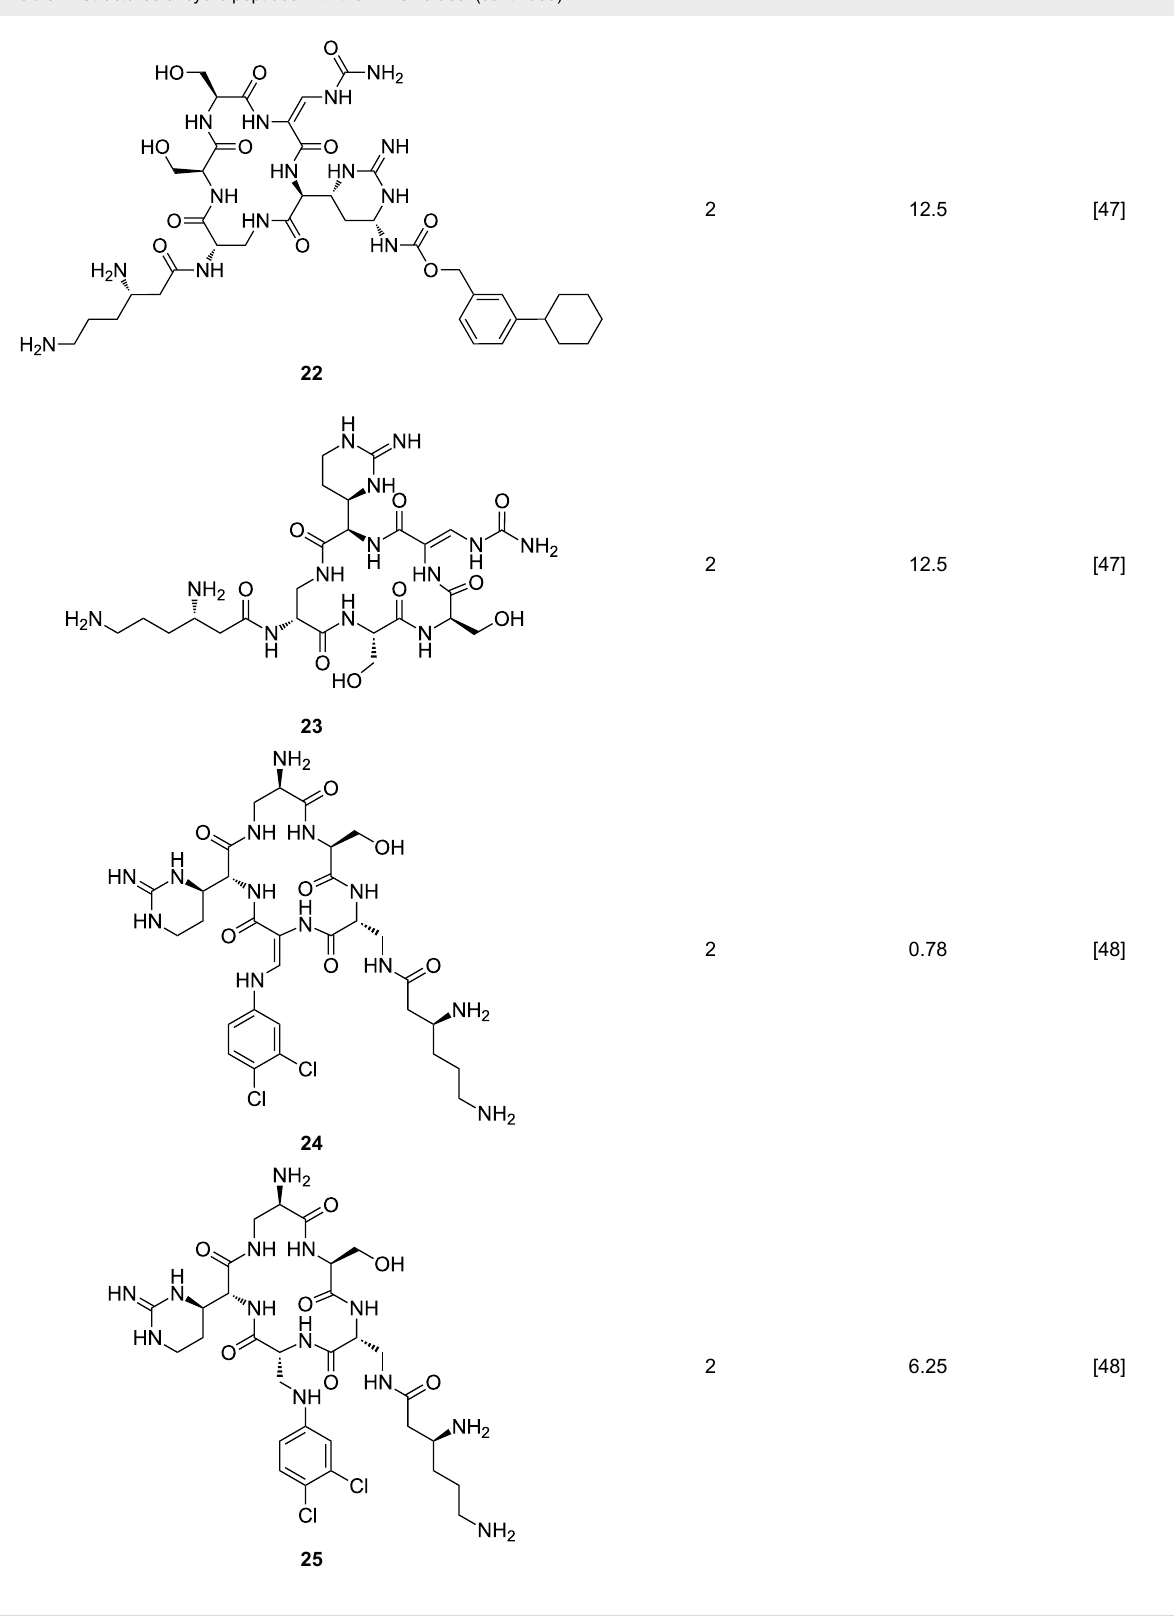
Table 1: Structures of cyclic peptides with their MIC values.